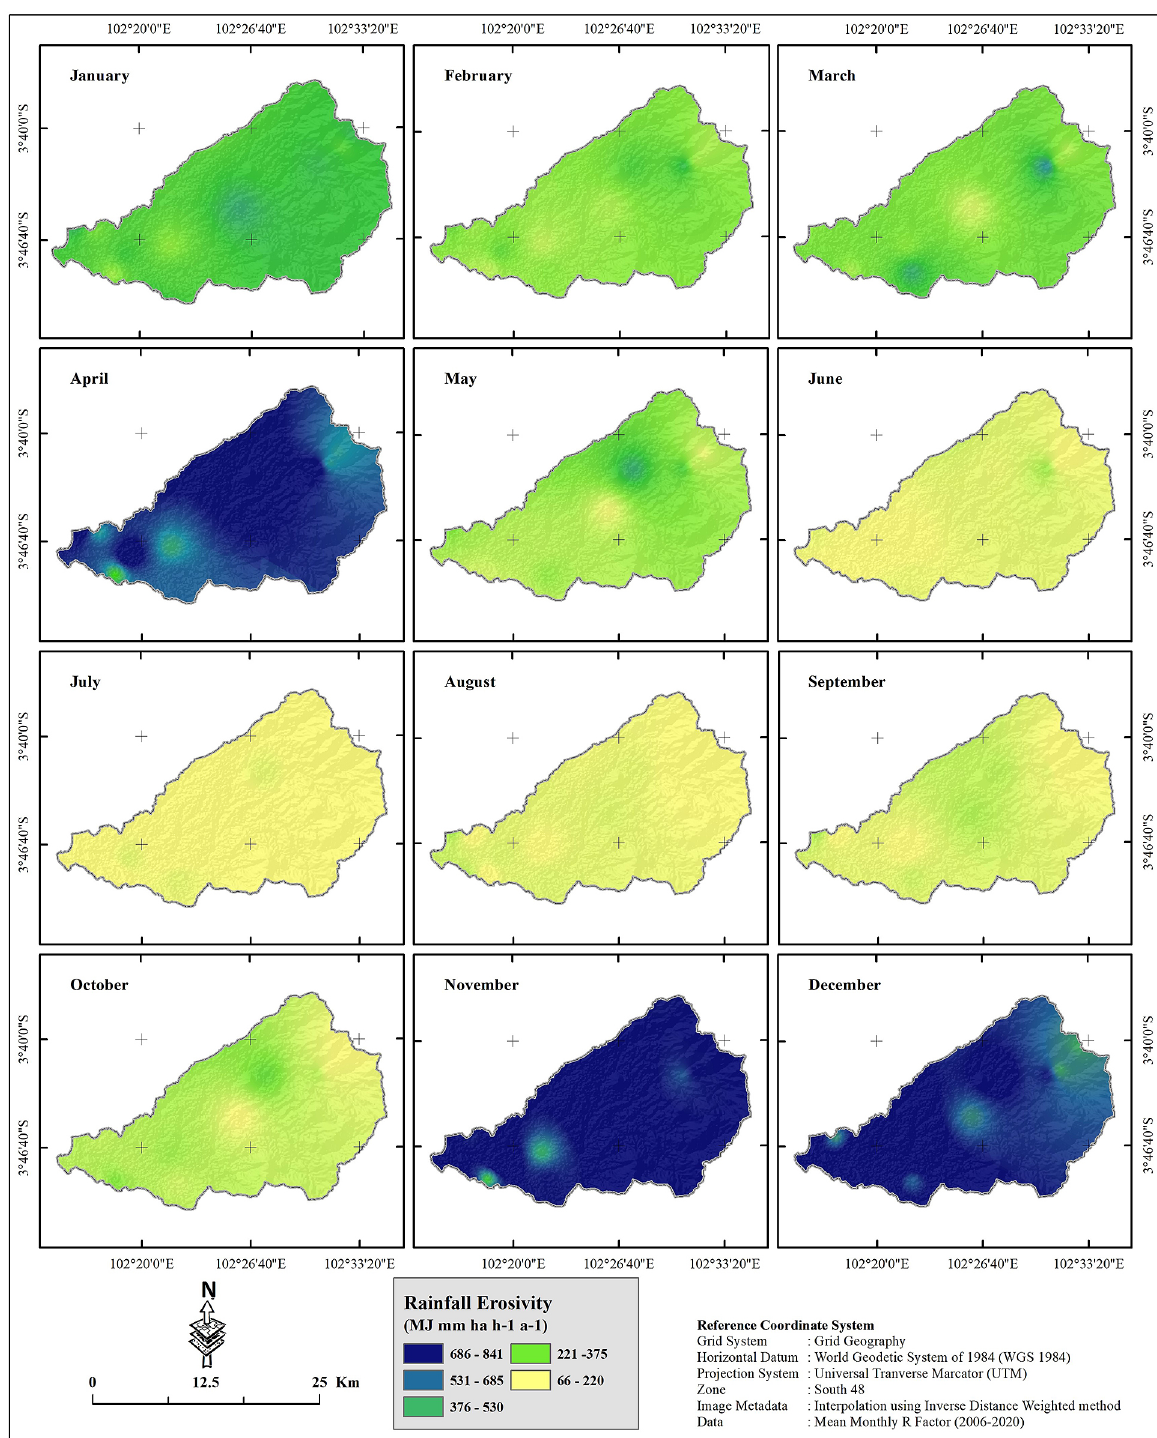
Fig. 3. Map of monthly rainfall erosivity in the Air Bengkulu watershed (same range from 66 MJ · mm −1 · ha −1 · h −1 · a −1 to >841 MJ · mm −1 · ha −1 · h −1 · a −1 ) using the IDW interpolation